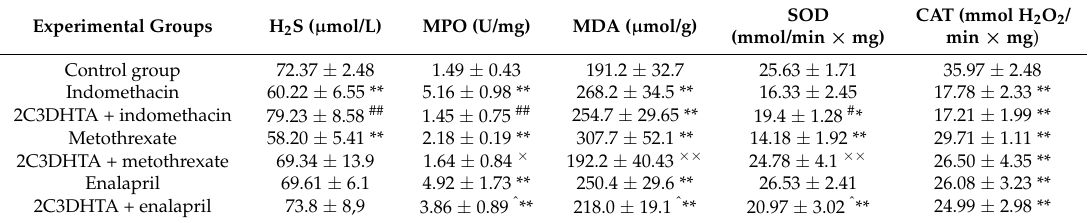
Table 3. The concentration of H 2 S in blood and activity of MPO and antioxidant enzymes (SOD and CAT) and concentration of MDA in small intestinal mucosa of rats with drug-induced enteropathies. Mean ± SD, n = 8 in each group of